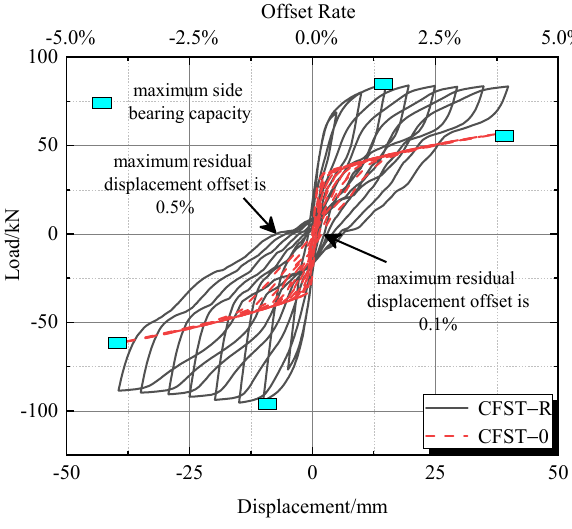
Figure 3. Hysteretic curve comparison.